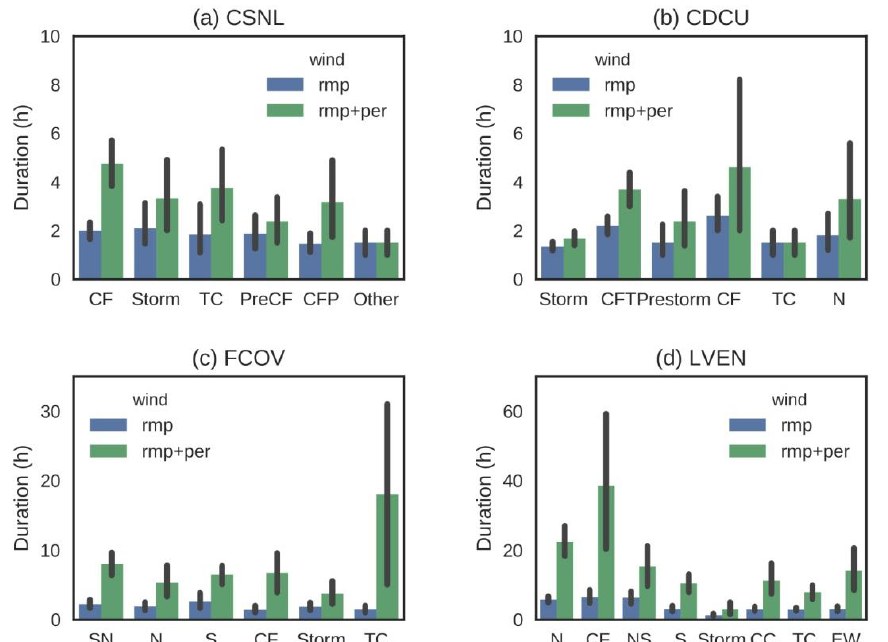
Figure 3. Wind-ramp duration and associated intense winds at ( a ) CSNL, ( b ) CDCU, ( c ) FCOV, ( d ) LVEN. Weather systems: Cold front (CF), Tropical Cyclone (TC), Pre-Cold Front (PreCF), Nortes (N), Surada (S), Transition Surada to Norte (SN), Easterly wave (EW), Cyclonic Circulation (CC). Cold front over Plateau (CFP) and cold front over FCOV (CFT). Rmp means wind ramp and (Rmp + per) refers to the wind ramp and persistence of intense winds.